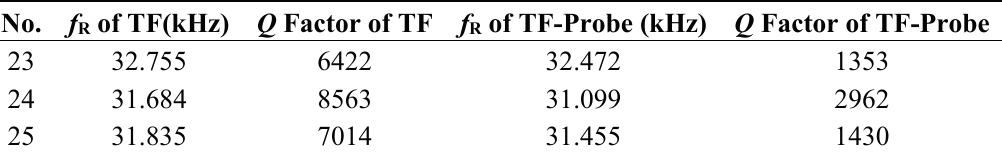
Figure 4. Resonance frequency and Q factor of TF. Table 3. Resonance frequency and Q factor of